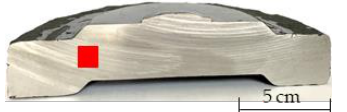
Figure 8. Location of the light microscopy images.